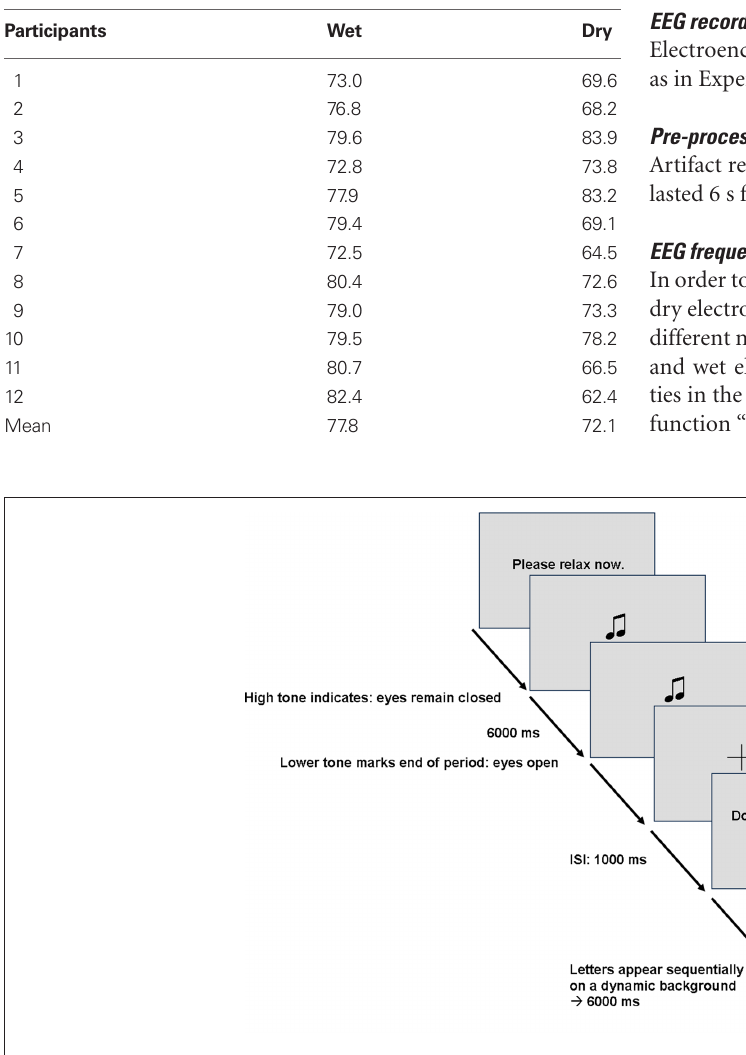
FiGurE 4 | Example trials for the experimental task of the paradigm to induce alpha activity. In the “engaged” condition, participants had to recognize a word in a sequence of letters presented on noisy background. In the “relaxed” condition, participants had to close their eyes and relax indicated by a high